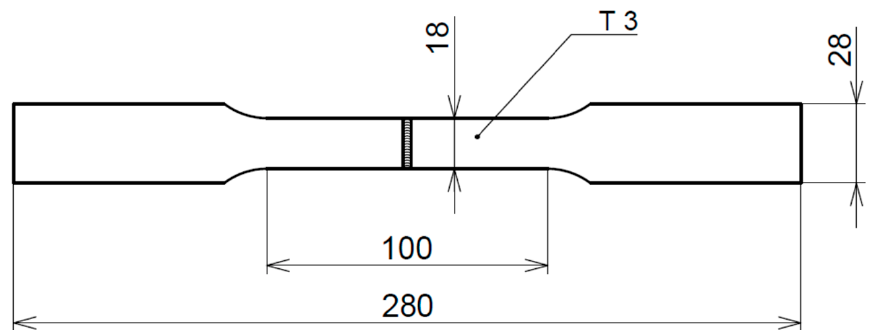
Figure 3. Dimensions of the tensile test specimen in mm.